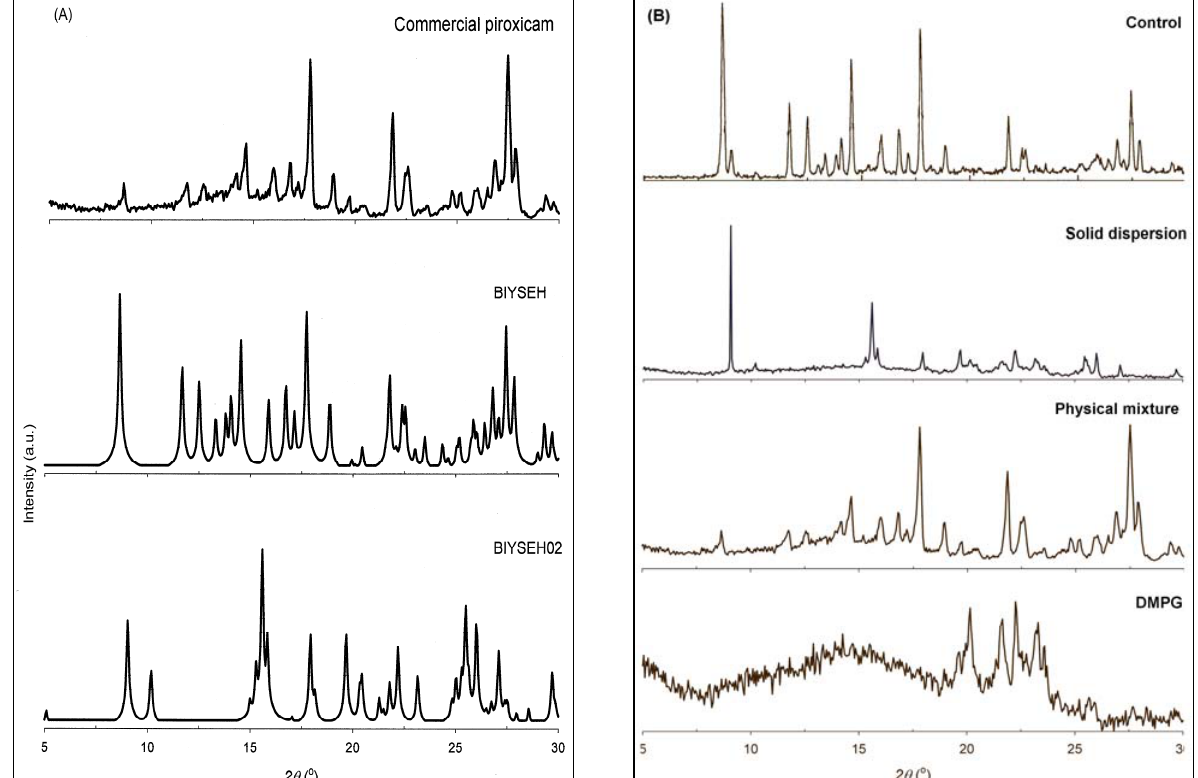
Figure 3. Powder X-ray diffraction patterns of ( A ) commercial piroxicam in comparison with theoretical patterns of its polymorphic forms, Form I (BIYSEH) and Form II (BIYSEH02), and ( B ) the carrier phospholipid DMPG, the 15:1 (w/w) piroxicam-DMPG physical mixture and solid dispersion vs . control